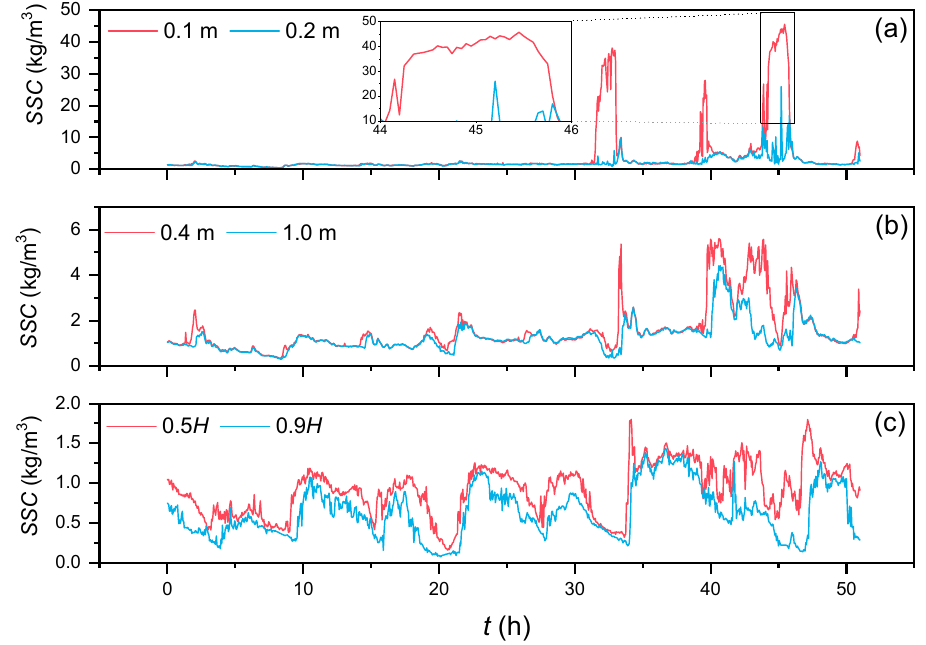
Figure 7. Time series of the in situ SSC measured at the middle of the Jiangsu coast, China, by the three types of turbidimeters (310TY, OBS-3A, and RBR solo 3 Tu), starting from 09:30 November 12, 2019. The mean water depth of the observation site is around 7 m.